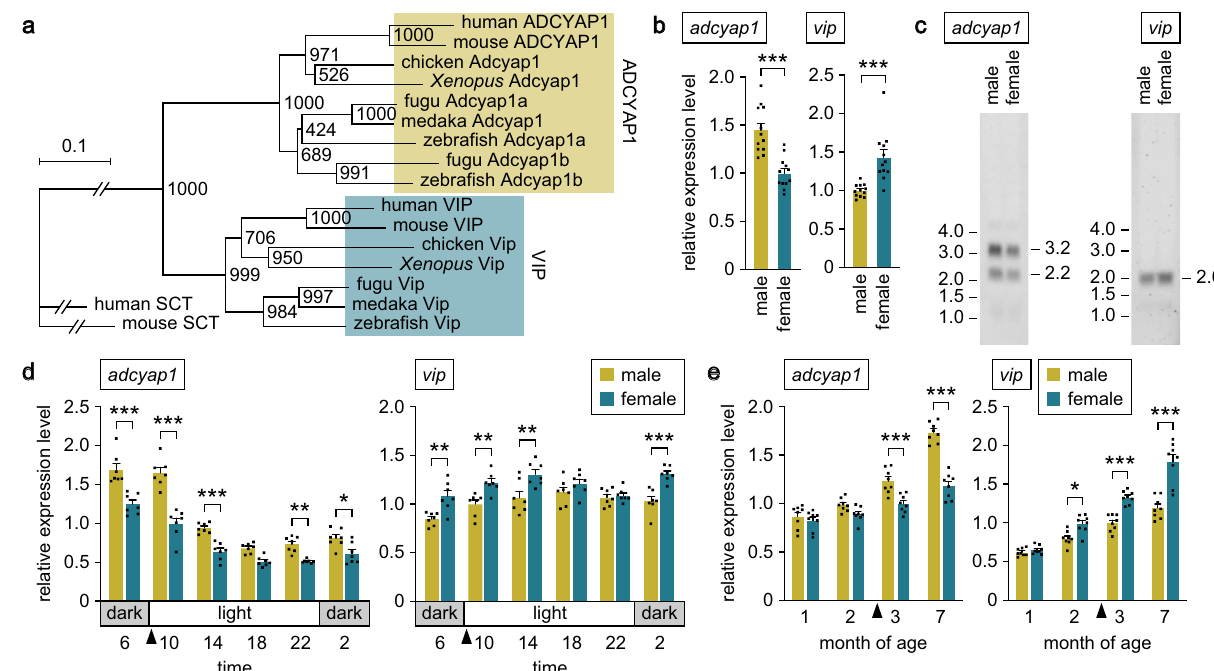
Fig. 1 adcyap1 and vip exhibit opposite patterns of sex-biased expression in the medaka brain. a Phylogenetic tree showing the relationship of medaka Adcyap1 and Vip to those of other species. The number at each node indicates bootstrap values for 1000 replicates. Scale bar represents 0.1 substitutions per site. SCT secretin. For species names and GenBank accession numbers, see Supplementary Table 2. b Con fi rmation/identi fi cation of sex-biased expression of adcyap1 and vip in the medaka brain by real-time PCR ( n = 12 per sex). c Detection of adcyap1 and vip transcripts in the male and female brain by northern blot analysis. Sizes (in kb) of RNA markers and the detected bands are indicated on the left and right, respectively. d Levels of adcyap1 and vip expression in the male and female brain throughout the diurnal/reproductive cycle ( n = 7 per sex and time). Arrowheads indicate the typical time of spawning. e Levels of adcyap1 and vip expression in the male and female brain during growth and sexual maturation ( n = 8 per sex and age). Arrowheads indicate the typical time of fi rst spawning. Quantitative data were expressed as means with error bars representing standard error of the mean. Statistical differences were assessed by unpaired t -test with or without Welch ’ s correction ( b ) and Bonferroni ’ s post-hoc test ( d , e ). * p < 0.05; ** p < 0.01; *** p <